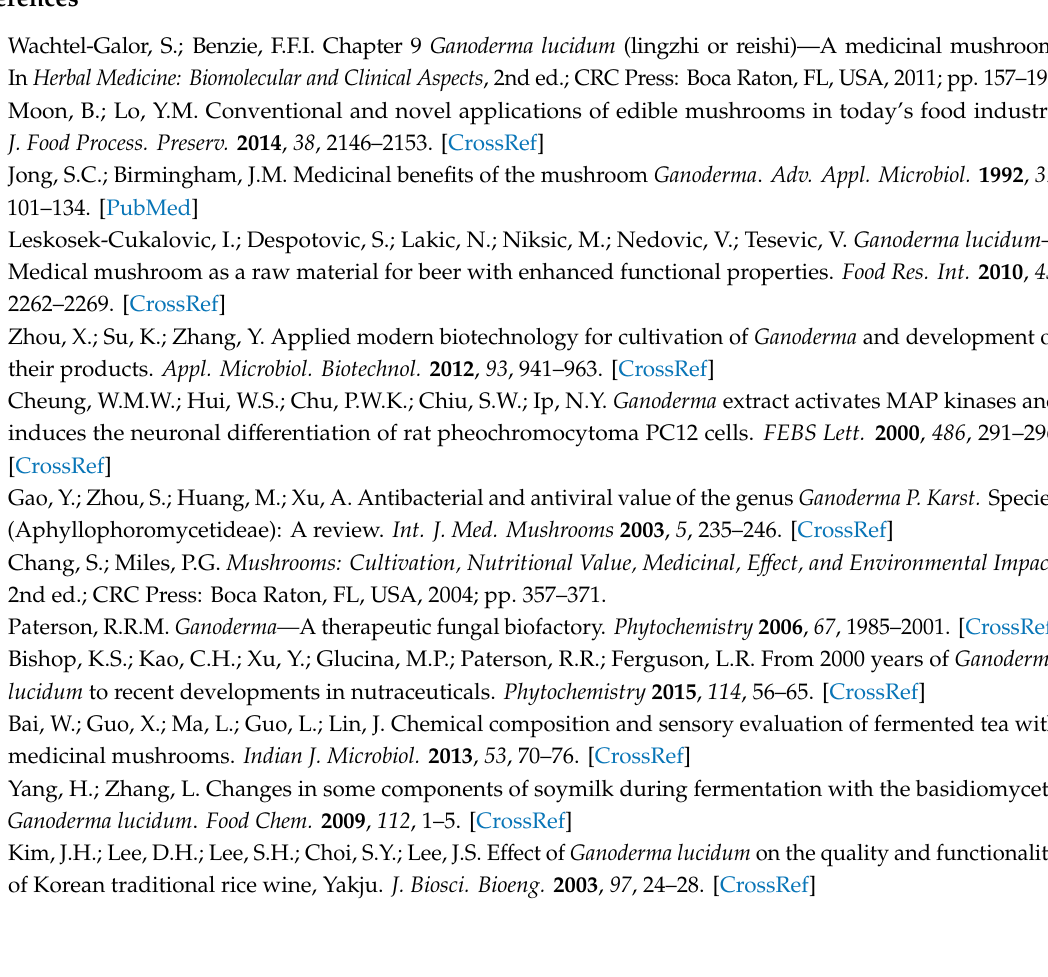
Figure S1: Shiraz winemaking process under specific conditions in the 28 L winemaking experiment, Figure S2: Weighted regression coe ffi cients of both aroma and flavor of red fruit (A and B), dried fruit (C and D) and mushrooms (E and F) notes, Table S1: Brix values ( ◦ ) measured by refractometer from the beginning to the end of small-scale fermentation of chemically defined grape juice media (CDGJM) and red grape juice (RGJ), Table S2: Impact of GL on liking, perceived sensory attribute overall intensity and CATA ratings from benchtop evaluations of commercial Shiraz wine spiked with GL (panel n = 32) and medium-scale pre-fermentation GL wines (panel n = 11) and Table S3: Significant sensory attribute intensity means of GL wines (from 28 L ferments) generated by RATA